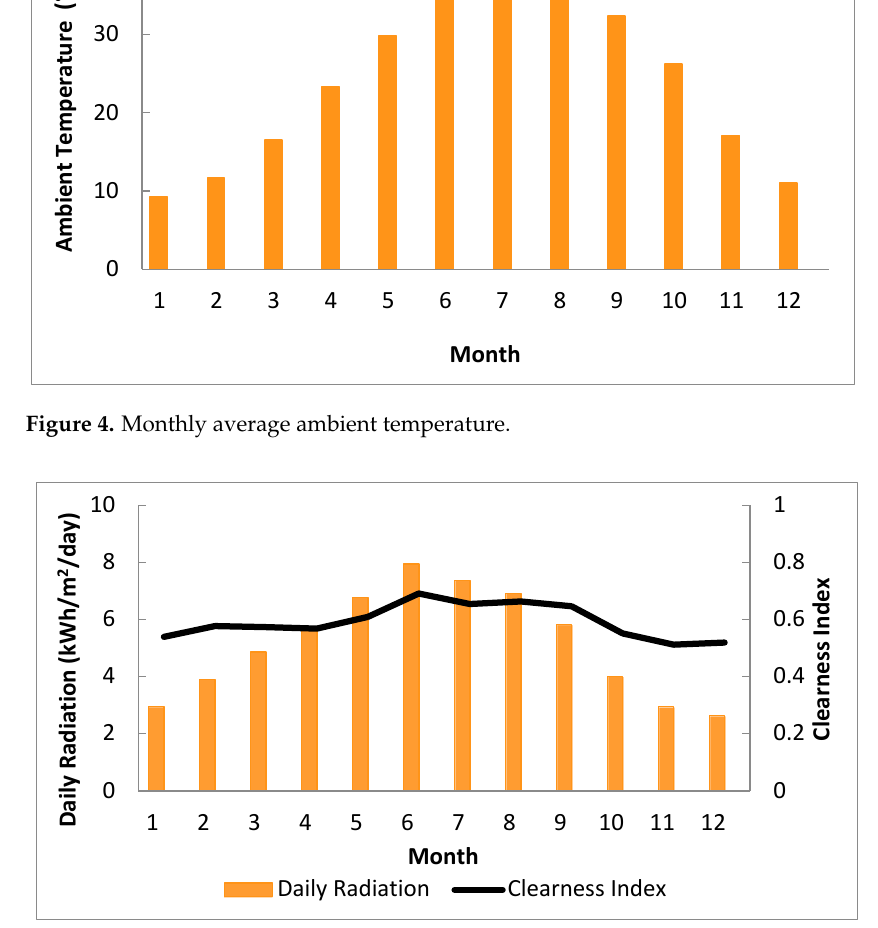
Figure 5. Monthly average solar radiation and clearness index.